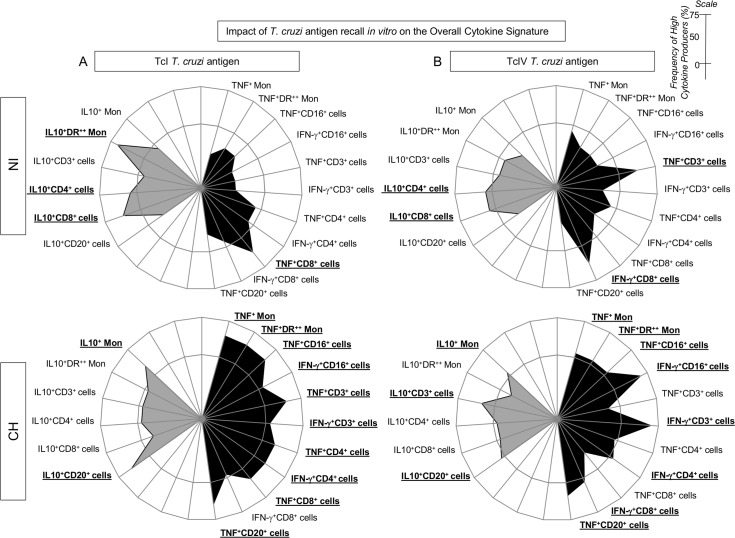
Overall cytokine signatures of T. cruzi-infected and non-infected macaques upon (TcI/TcIV)/T. cruzi-antigen recall in vitro.Radar charts were plotted to characterize the impact of (A) TcI and (B) TcIV T. cruzi antigen recall in vitro on the pro-inflammatory (black area) and modulatory (gray area) cytokine pattern of naturally infected cynomolgus macaques (CH) and non-infected controls (NI). The frequencies of high cytokine producers confined outside the inner circle (50th percentile) are underscored by bold underline format.